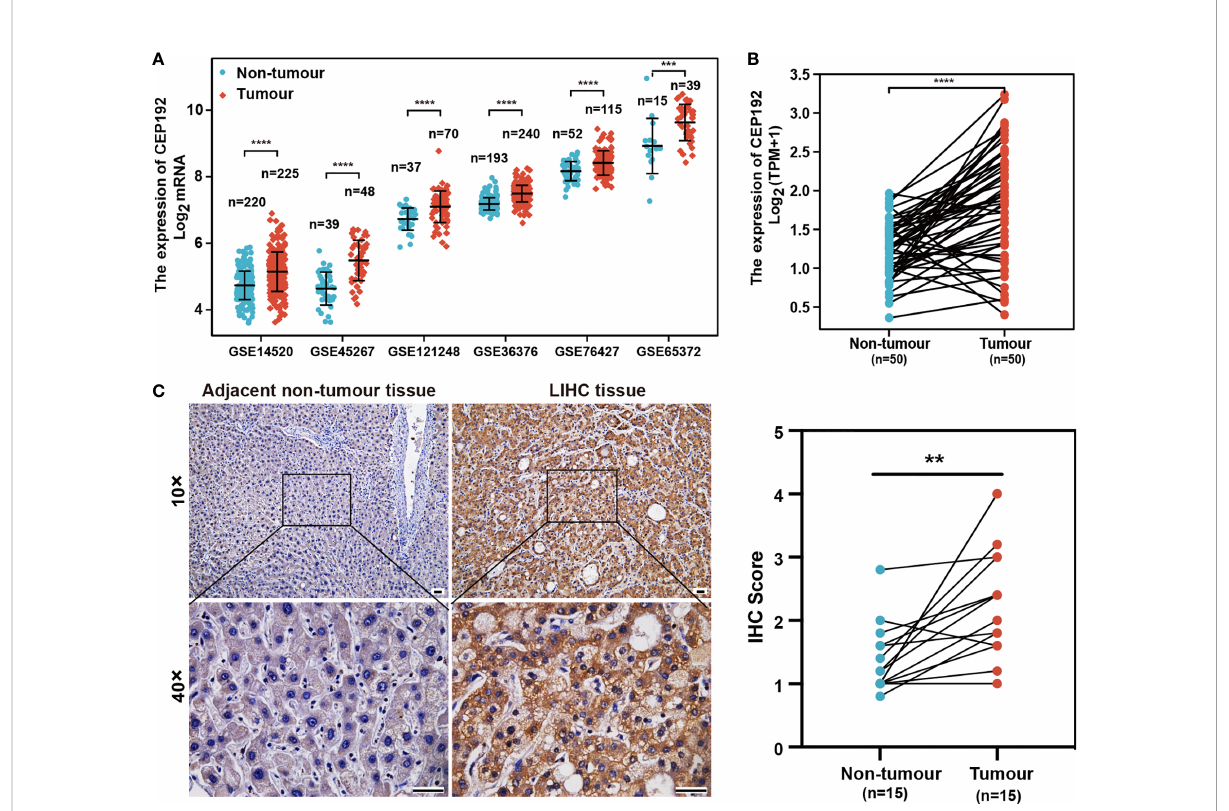
FIGURE 1 CEP192 was overexpressed in human HCC tissues. (A) CEP192 was highly expressed in human HCC tissues (T) versus adjacent non-tumor tissues (N) based on the RNA-seq data from the GEO database including GSE14520 (T, n = 225; N, n = 220; mean ± SEM, Mann – Whitney test), GSE45267 (T, n = 48; N, n = 39; mean ± SEM, t -test), GSE121248 (T, n = 70; N, n = 37; mean ± SEM, Mann – Whitney test), GSE36376 (T, n = 240; N, n = 193; mean ± SEM, Mann – Whitney test), GSE76427 (T, n = 115; N, n = 52; mean ± SEM, t -test), and GSE65372 (T, n = 39; N, n = 15; mean ± SEM, t -test); *** p <0.001, **** p <0.0001. (B) CEP192 expression was increased in 50 HCC samples compared to their matched non- tumor liver samples according to the RNA-seq data analysis of TCGA; paired t -test, **** p <0.0001. (C) Representative IHC images demonstrated higher levels of CEP192 in HCC tumor tissues compared with adjacent non-tumor liver tissues (scale bar: 200 m m). The IHC images were quanti fi ed with an IHC score using ImageJ ( n = 15); paired t -test, ** p